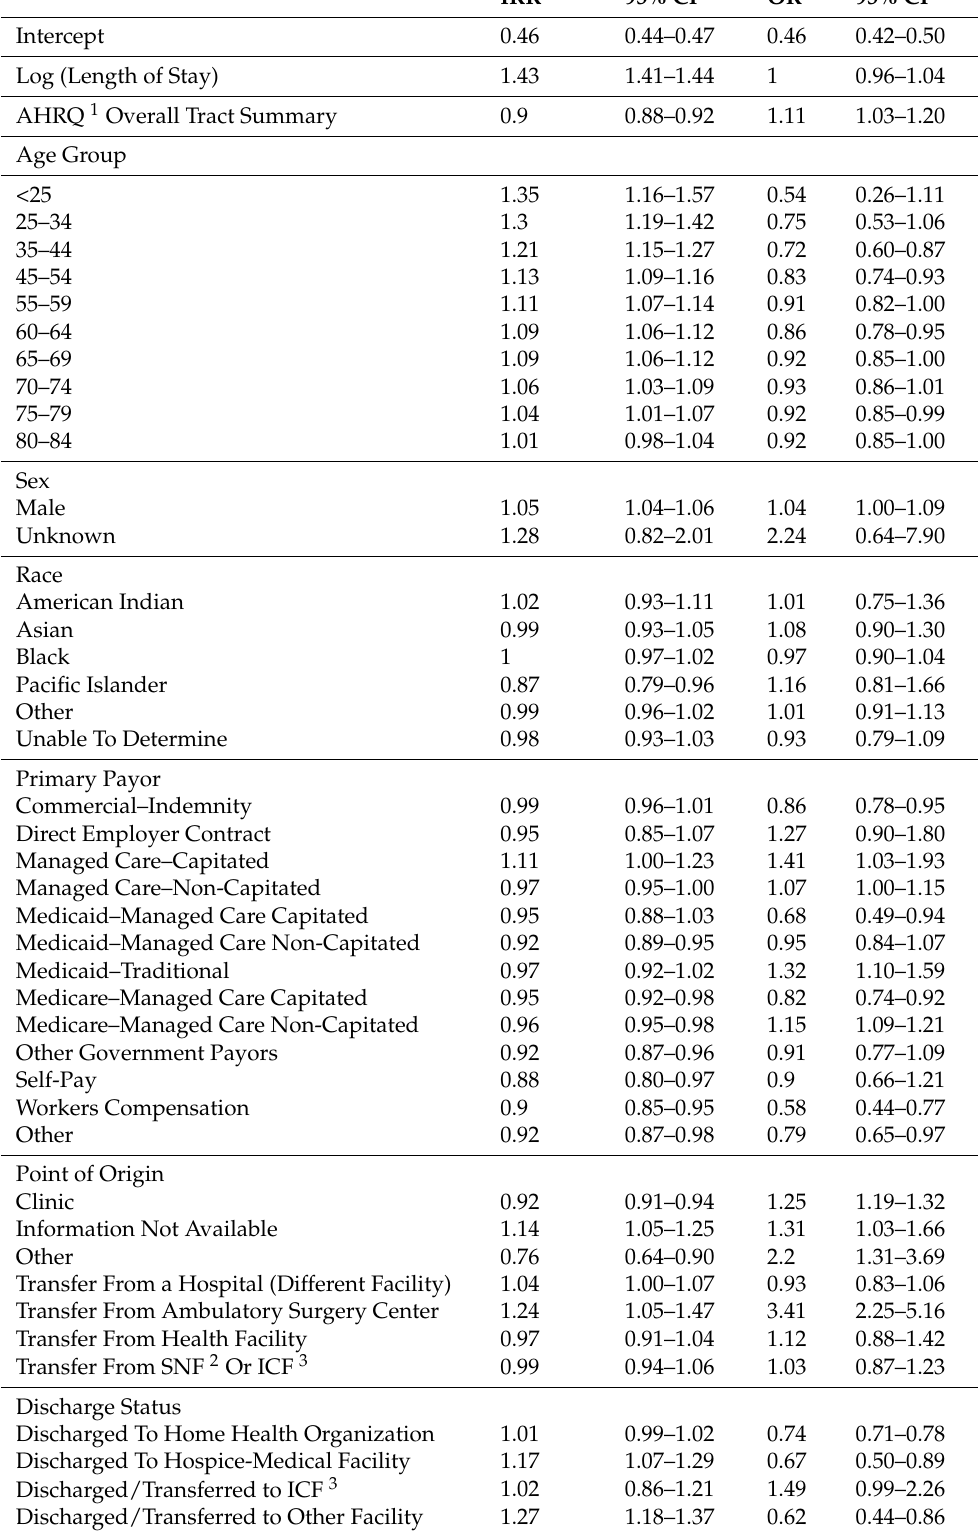
Table 2. Zero-inflated Poisson regression incidence rate ratios (IRRs) and odds ratios (ORs), and corresponding 95% confidence intervals (CIs), for additional procedure